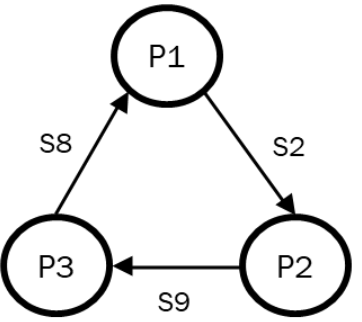
Figure 12. Graph diagram of the adjacency ordering for surface 1 of Scenario 3.